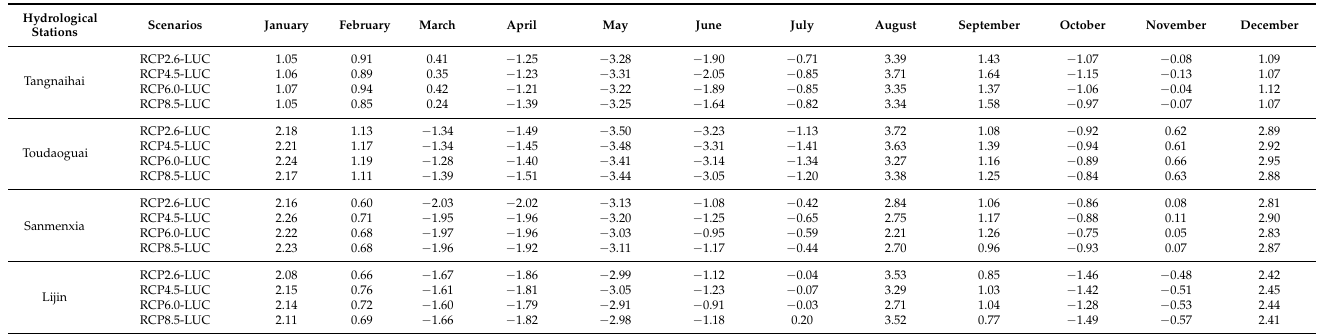
Table 8. The differences between the monthly runoff proportion in the future period and the base period of the four hydrological stations